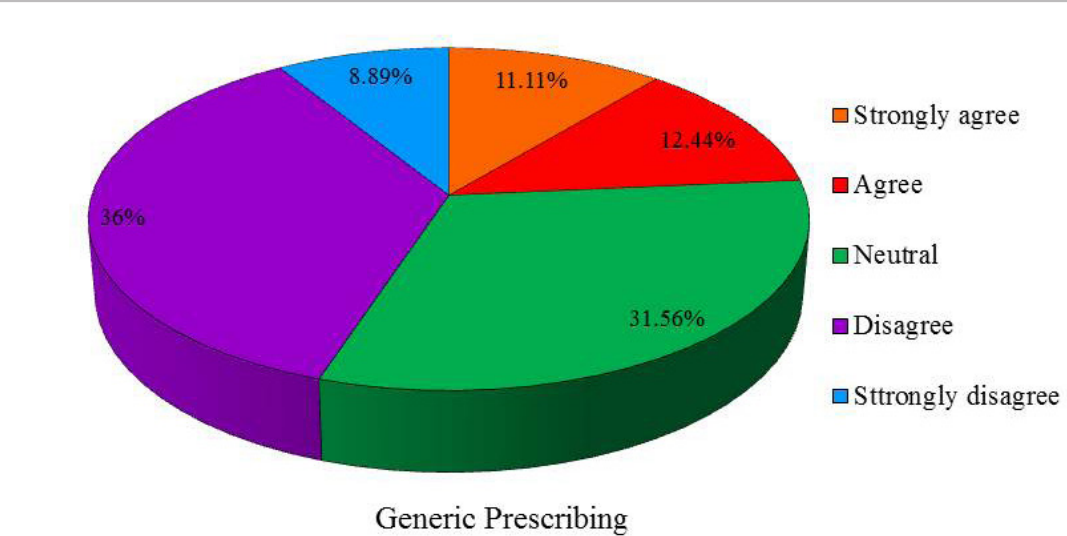
FIGURE 6 - Hospital prescribers’ views of generic